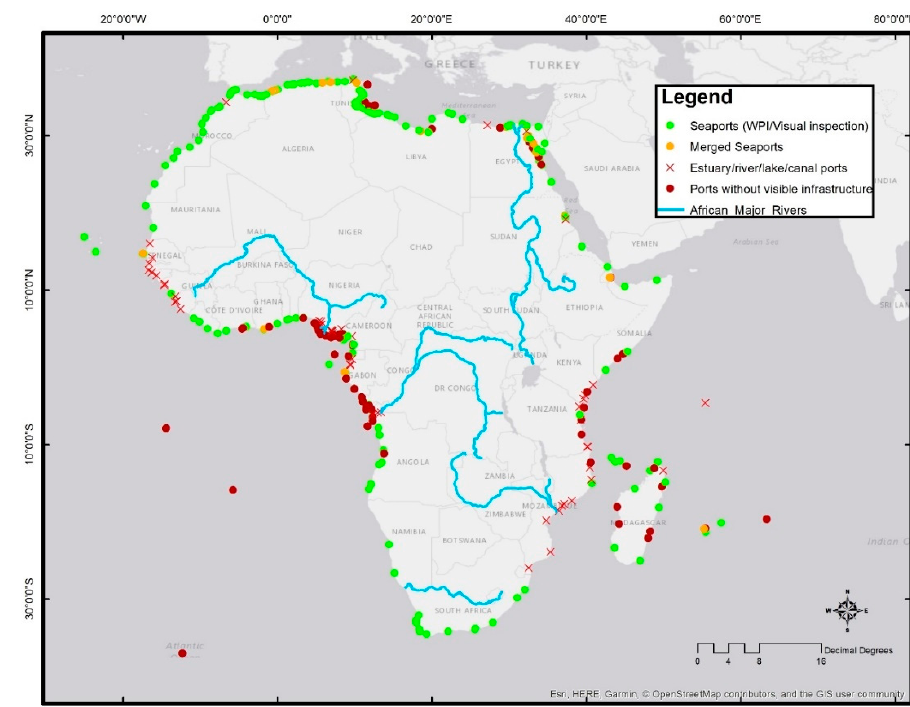
Figure 1. Overview of the geographical locations of the African ports that were initially identified. The seaports included in this study are indicated in green, consisting of seaports from the World Port Index complemented with additional ports identified from recent satellite imagery (green dots), and merged seaports (orange dots). Ports excluded from this study are indicated in red, consisting of ports located at rivers, lakes or canals (red crosses), and ports without clearly visible structures on the latest high-resolution satellite imagery (red dots).